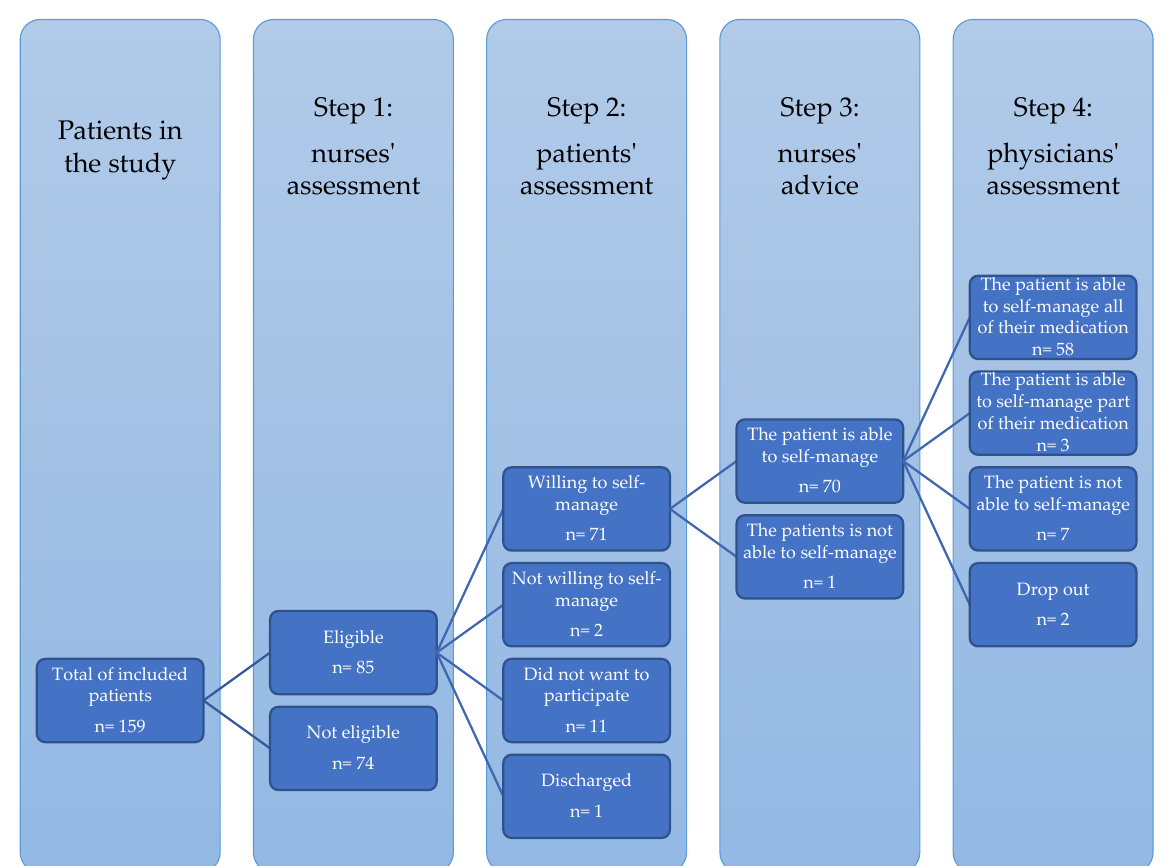
Figure 1. Flowchart of the participants in the study.